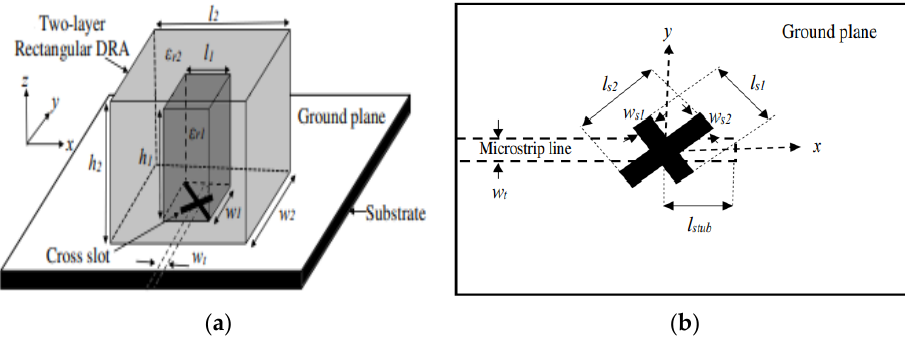
Figure 8. Proposed rectangular DRA: ( a ) 3D view; ( b ) top view of the microstrip feedline [49]. A wideband CP DRA using a single feed can be obtained using parasitic vertical plates as proposed in [51]. By presenting four metallic plates around the dielectric resonator, a very wide AR bandwidth can be generated with the contribution from the cross-slot-fed DRA, the revolved metallic plates, and the interaction among the dielectric resonator and metallic plates. The AR bandwidth of the conventional DRA is successfully enhanced from ~10% to ~46.9% without increasing either the dimension or height of the antenna. The proposed antenna is fed with a microstrip-coupled cross-slot at the bottom, as shown in Figure 9. However, the position of the metallic plates ( dx , dy ) has an effect on the AR. The AR value will be degraded if the value of dx is 0 or negative. Thus, we need to maintain the positive value of dx for a good AR value.